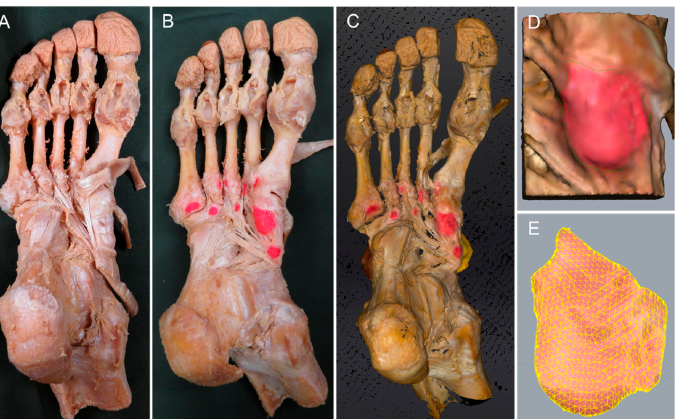
Figure 1. Method for measuring site of attachment. ( A ) Site of attachment of the tibialis posterior tendon: right foot, plantar view. ( B ) The site of attachment was identified by peeling the adherent tissue, then coloring the site with red pencil. ( C ) The surface area was measured using a 3D scanner to make the foot sample three-dimensional. ( D ) Enlarged view of the medial cuneiform bone. A curve is drawn as the boundary of the site of attachment of the navicular bone with a pen-type device. ( E ) Surface area was calculated using Rhinoceros 3D software.